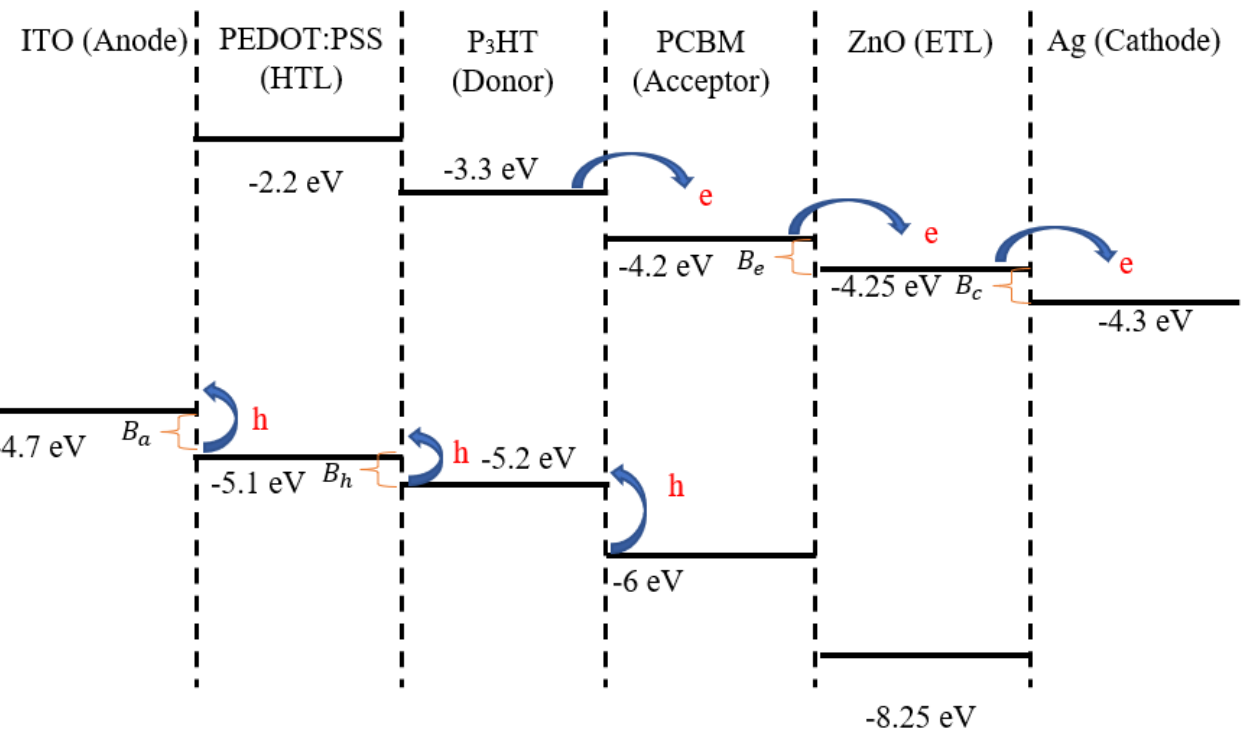
Figure 1. Schematic energy level alignment of functional materials used in the OSC, comprising a layer configuration of ITO/PEDOT:PSS (40 nm)/P 3 HT:PCBM (90 nm)/ZnO (10 nm)/Ag (100 nm).